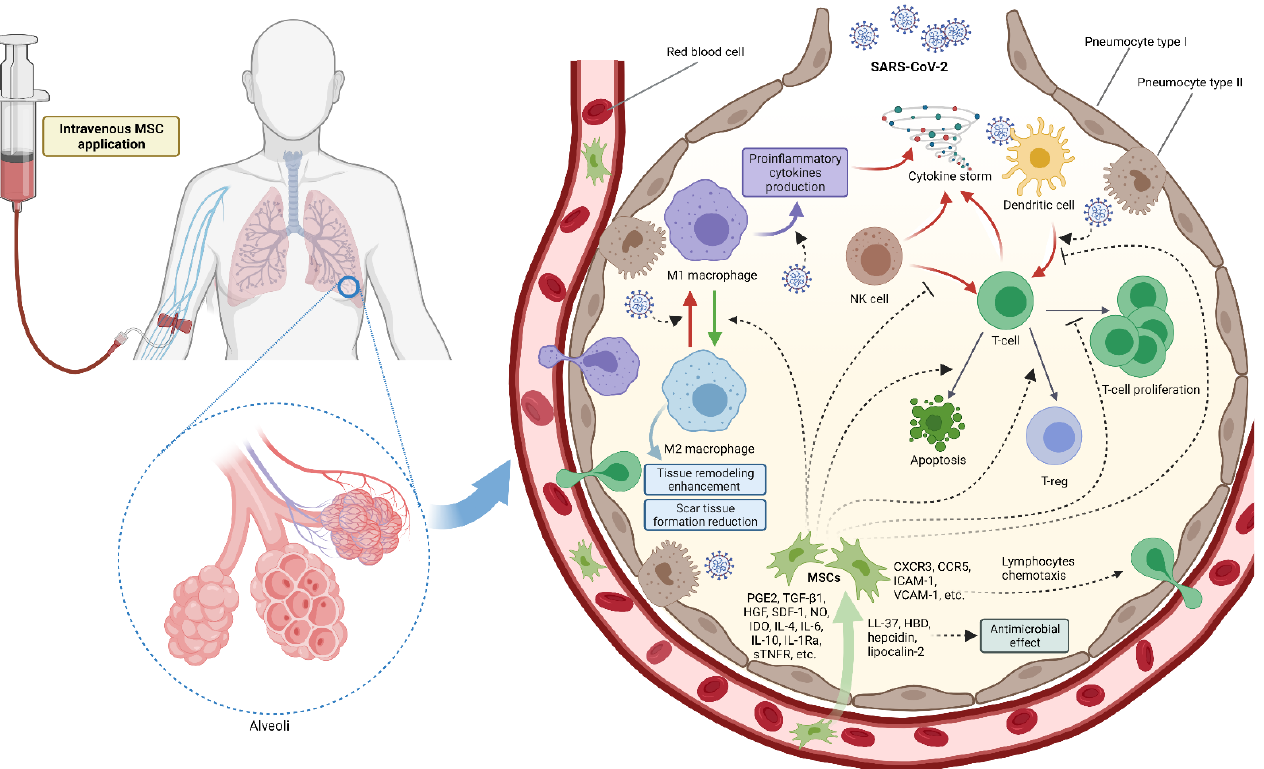
Figure 1. Presumed effect of COVID-19 mesenchymal stem cell therapy. Intravenous administration enables MSCs to travel to the lung microvasculature. MSCs extravasate in the alveoli and are then found in the proinflammatory microenvironment caused by the replication of the virus and subsequent immune response, causing the “cytokine storm”. MSCs are stimulated by the surrounding cytokines and respond by secreting molecules that suppress inflammation, have an antimicrobial effect, cause lymphocyte chemotaxis, stimulate macrophages to change their phenotype from proinflammatory M1 phenotype to anti-inflammatory M2 phenotype. They also inhibit T-cell proliferation and induce T-cell apoptosis